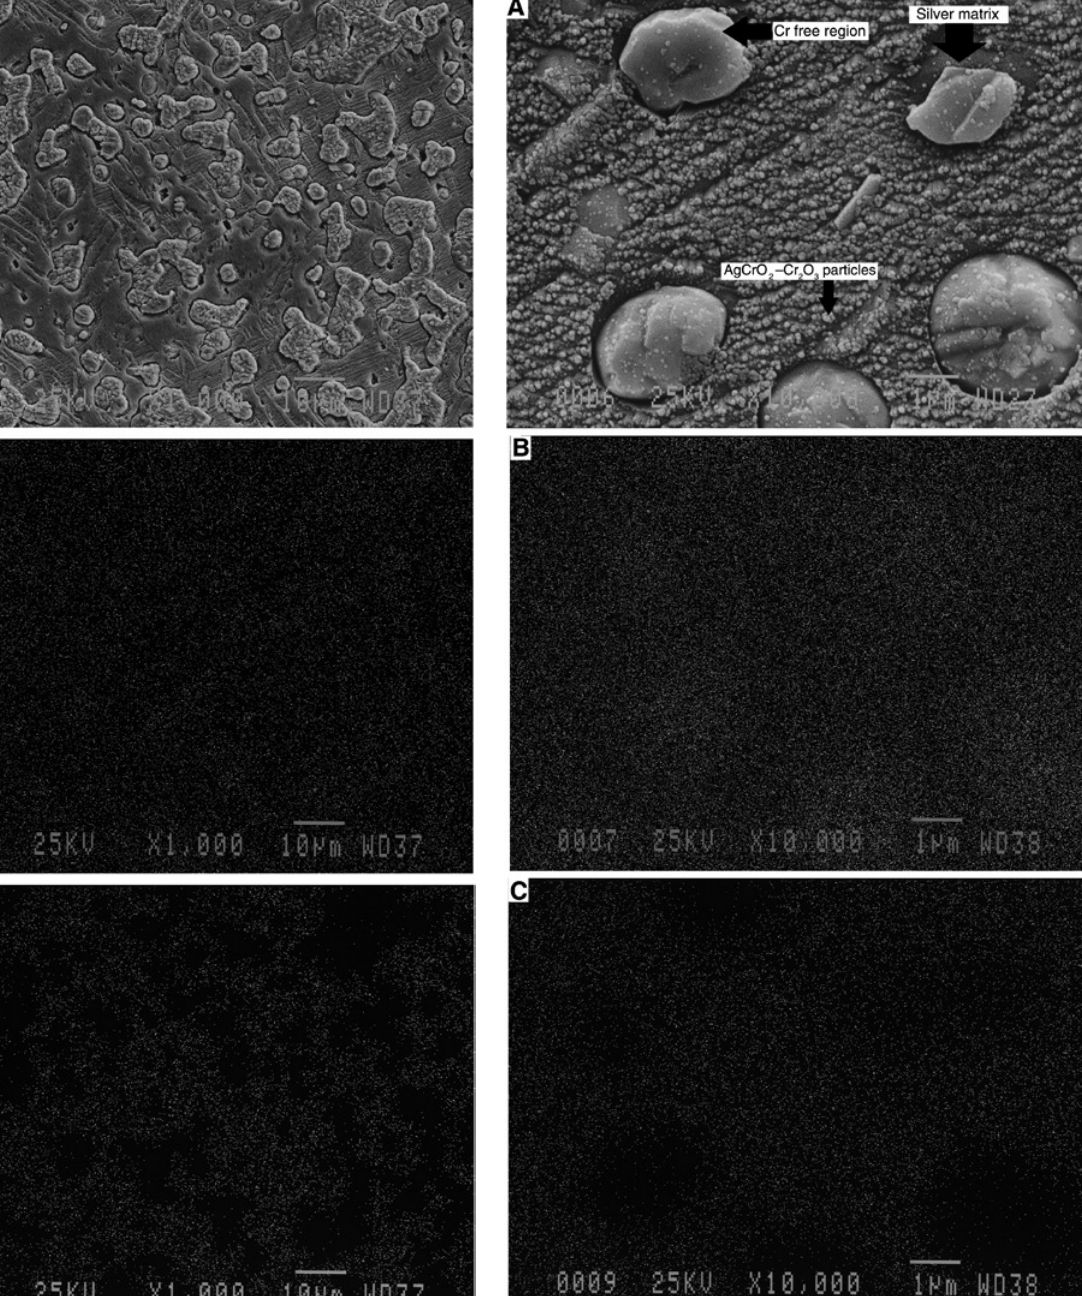
Figure 7: Microstructure of the sintered samples: (A) SEM image of densified samples. Different regions of the microstructure are shown by arrows. (B) Corresponding elemental map analysis of silver. (C) Corresponding elemental map analysis of